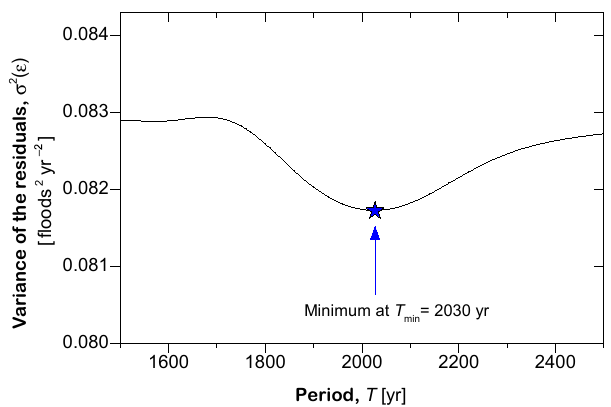
Figure D1. Shown is the variance of the residuals ( σ 2 (ε)) for fitting a sinusoidal function (Eq. 16) to the floods per year series n year as a function of the period T of this periodic function. The function for the variance of the residuals has a minimum at T min = 2030years (shown as a star in the